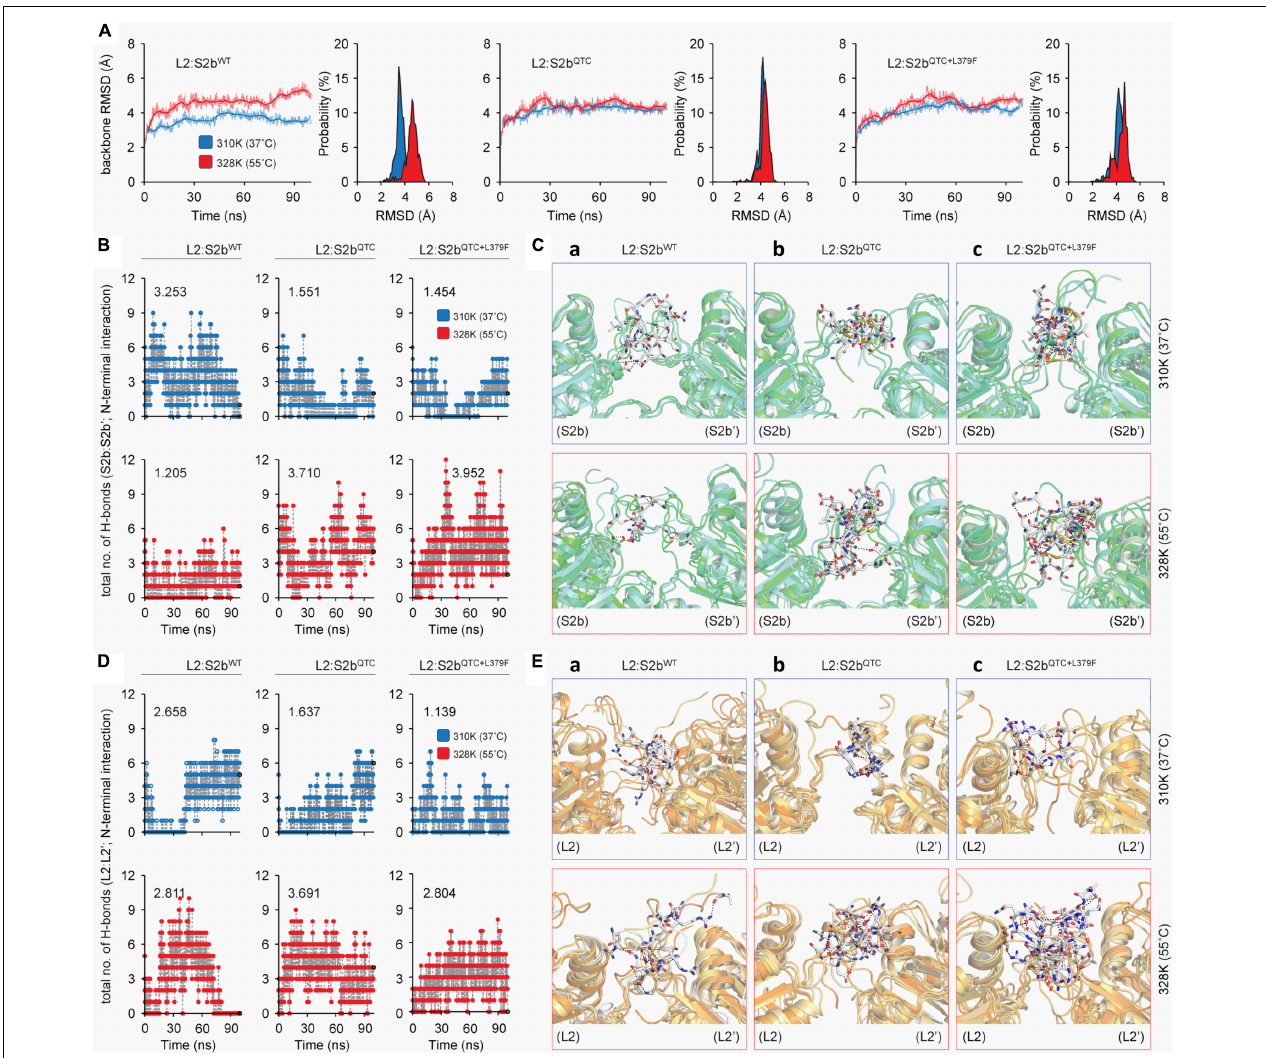
FIGURE 6 | Molecular dynamics analysis of L2:S2b complexes at two different temperature conditions (37 and 55 ◦ C). (A) Backbone RMSD of L2:S2b complexes (wild type, QTC and PQ6 mutants). (B) Intermolecular H-bonds formed in S2b:S2b (cid:48) interface (blue, 37 ◦ C; red, 55 ◦ C). (C) Superimposed view of intermolecular interaction(s) at 25 ns between S2b:S2b (cid:48) interface (upper panel, 37 ◦ C; lower panel, 55 ◦ C). (D) Intermolecular H-bonds formed at the L2:L2 (cid:48) interface (blue, 37 ◦ C; red, 55 ◦ C). (E) Superimposed view of intermolecular interaction(s) at 25 ns between L2:L2 (cid:48) interface (upper panel, 37 ◦ C; lower panel, 55 ◦ C). The S2b and L2 subunits’ N-terminal loop regions are displayed in light-green and light-orange cartoons, respectively, and the interacting residues are presented in white stick models. The black-dotted lines represent the intermolecular polar contacts between two S2b subunits and between two L2 subunits.